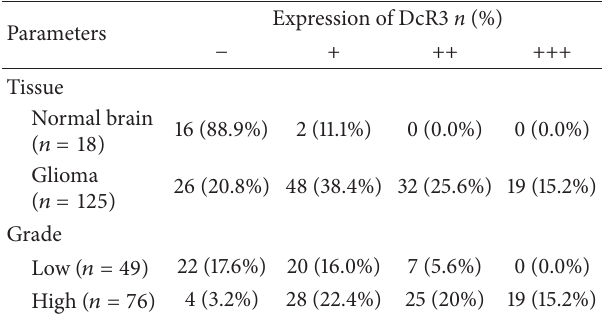
Table 1: Relationship between DcR3 expression and glioma differ- entiation.